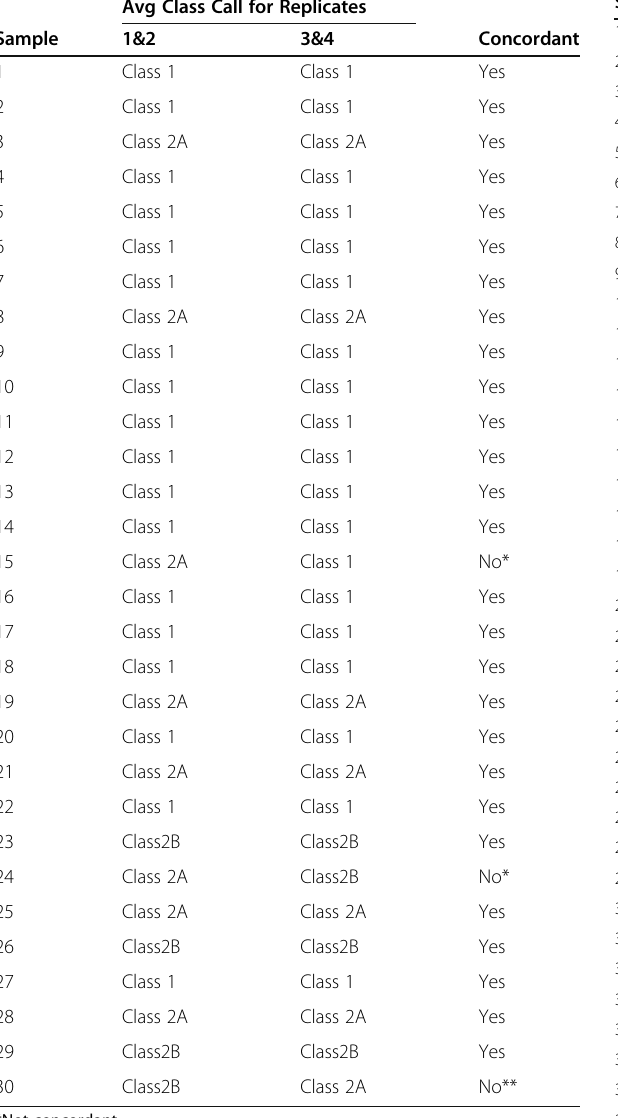
Table 1 Inter-assay summary data for replicates 1 and 2 vs 3 and 4 were used for the evaluation of Class call concordance. 30 FFPE available samples were run in duplicate, for a total of 4 replicates, over 2 days by two different technologists and using two different machines. The individual sample class call averages of the replicates are shown